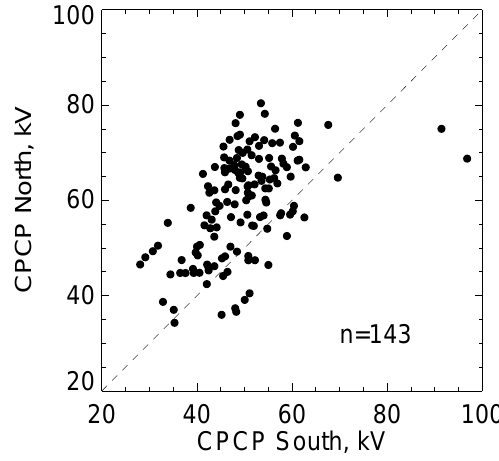
Fig. 3. Scatter plot of SuperDARN CPCP for the Northern (sum- mer) Hemisphere versus SuperDARN CPCP for the Southern (win- ter)